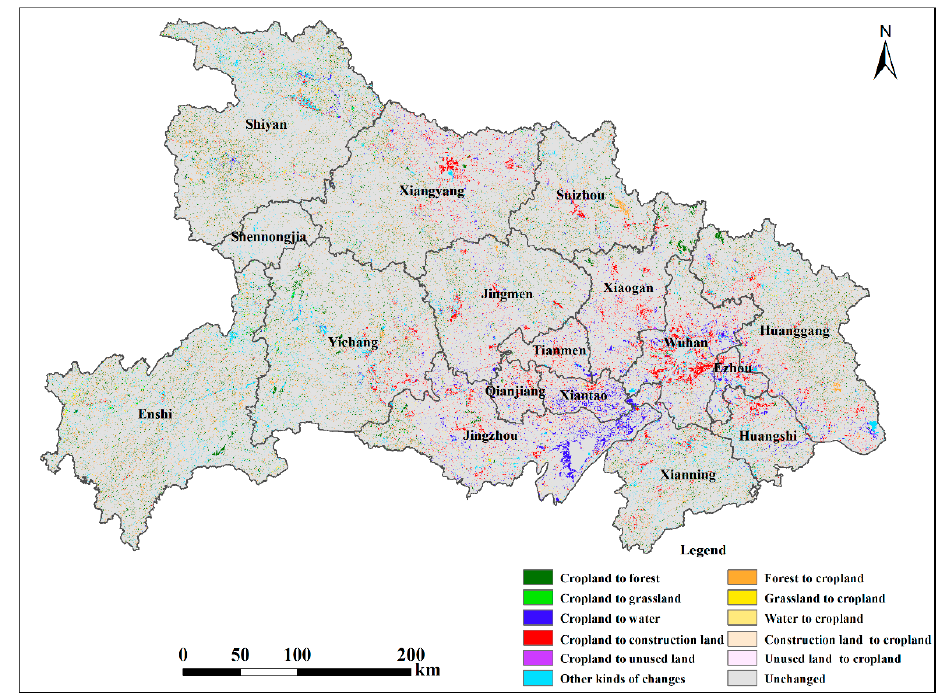
Figure 3. Land use conversion between 2000 and 2018.